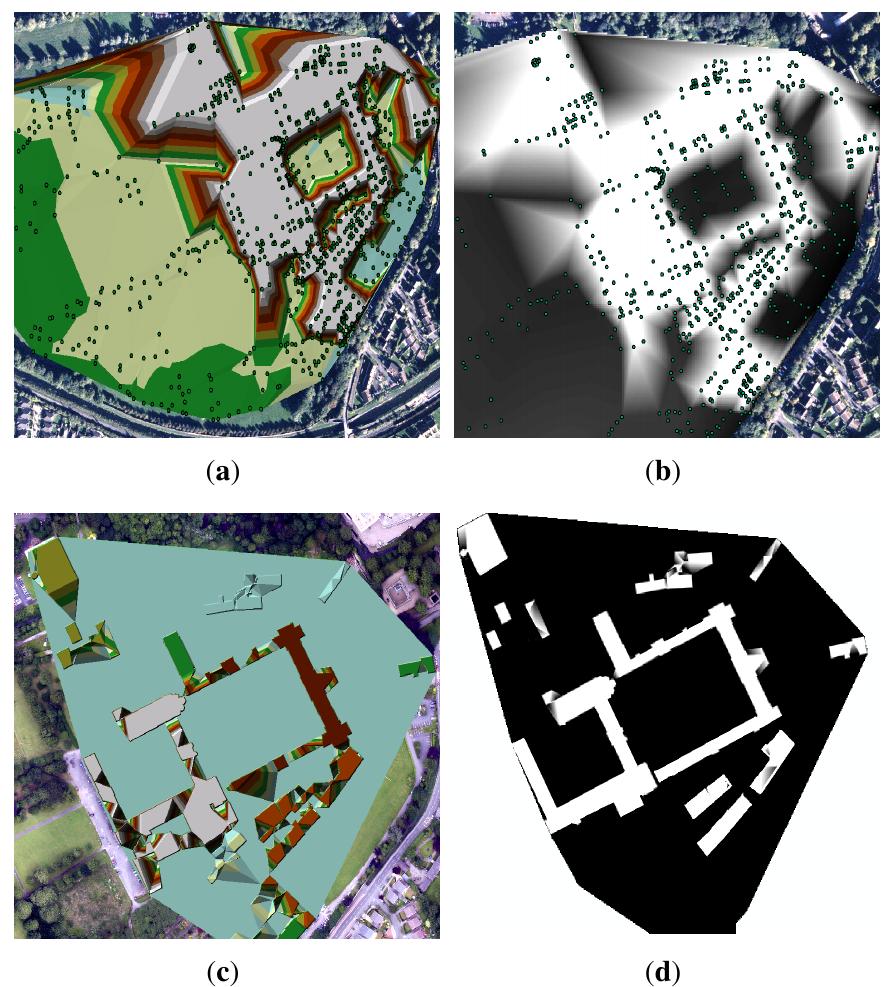
Figure 7. Creating surfaces to model obstructions ( a ) TIN without 1 m offset exhibits poor definition of elevation changes ( b ) low quality raster DSM created using TIN without 1 m offset ( c ) 1 m offset results in an improved TIN ( d ) improved TIN results in an improved raster DSM.